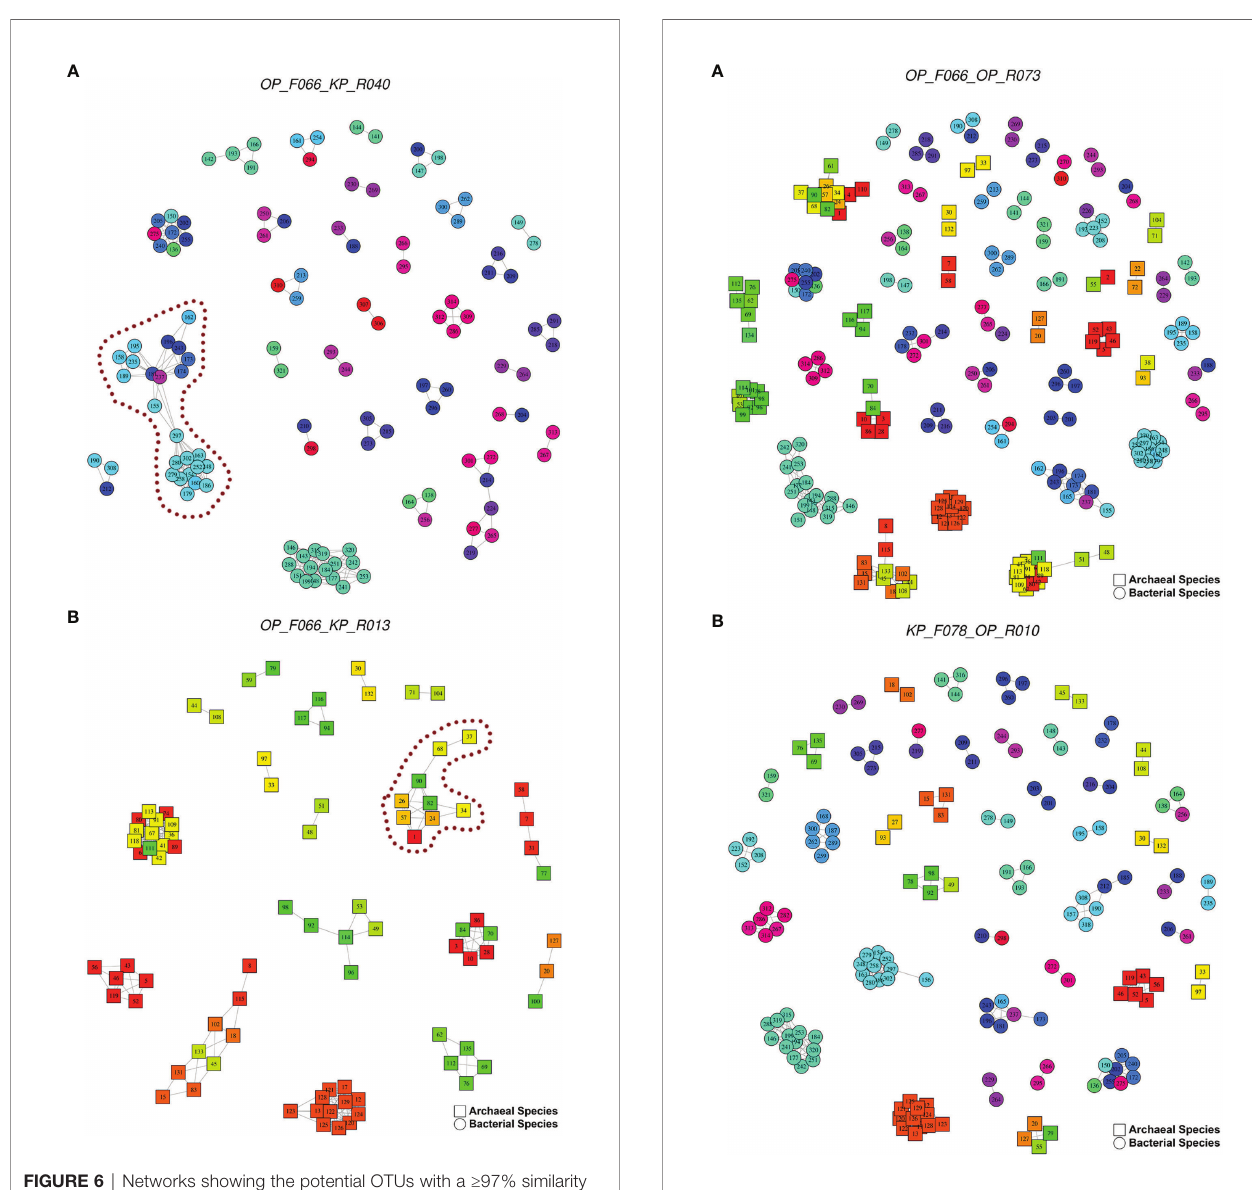
FIGURE 7 | Networks showing the potential OTUs with a ≥ 97% similarity threshold obtained with the primer pairs for bacteria and archaea. (A) OP_ F066-OP_R073 (219 species with ASI97, 525 ASI97). (B) KP_F078- OP_R010 (primer pair widely used in the oral microbiome literature; 155 species with ASI97, 314 ASI97). In the graphs, each node represents an oral species, the color indicates the genus and the number refers to the species identi fi er, whose assigned species are detailed in the Supplementary Tables 1 , 2 . Each edge represents the presence of a ≥ 97% similarity between different species. resulting in clusters of possible OTUs. The graphs were made using the igraph package (version 1.2.6) (Csardi and Nepusz,